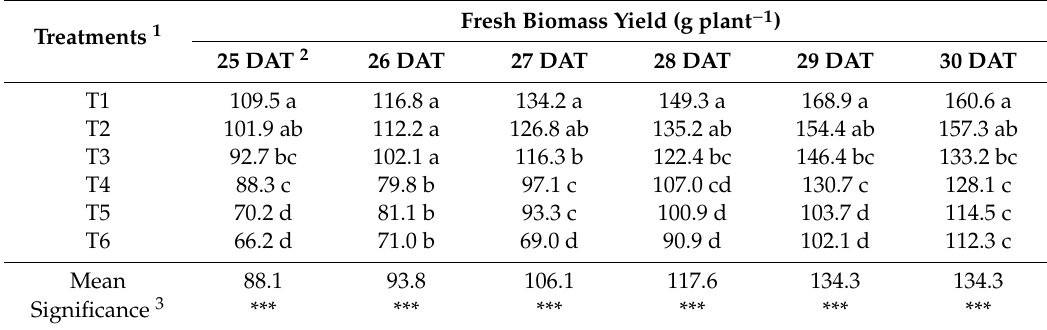
Table 5. Spring trial: fresh biomass yield of lettuce per type of fertilization treatment. Treatments